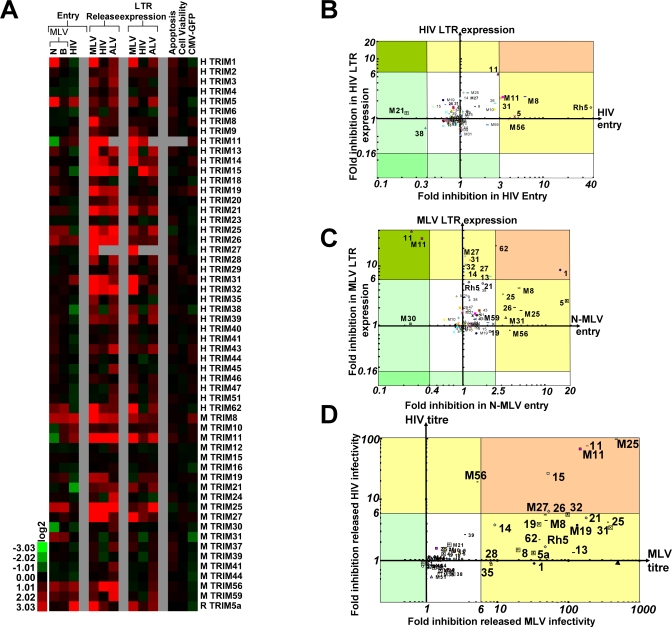
Anti-retroviral Activities of TRIM Proteins Identified in This Study(A) A Java TREEVIEW graphic display of all TRIM proteins activities against early and late stages of the retroviral life cycle. Input fold inhibition values were log2 transformed and shown as red/green color-coding for inhibitory and enhancing activities, respectively. Grey stands for experiments not carried out.(B–D) Scatter plot analyses were performed as indicated.